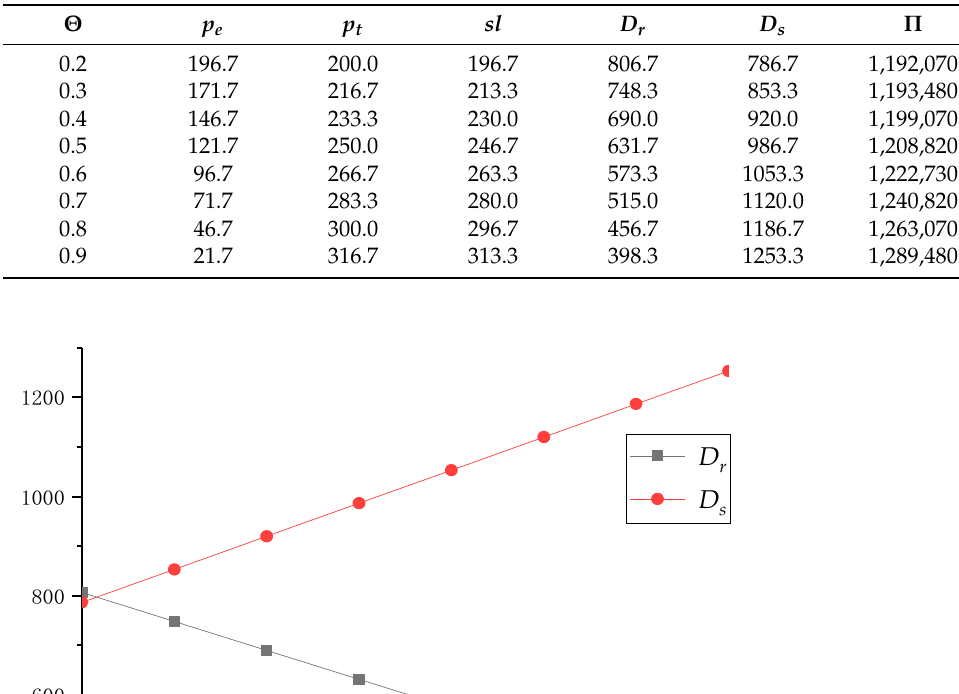
Table 2. The effect of Θ on decision and profit.